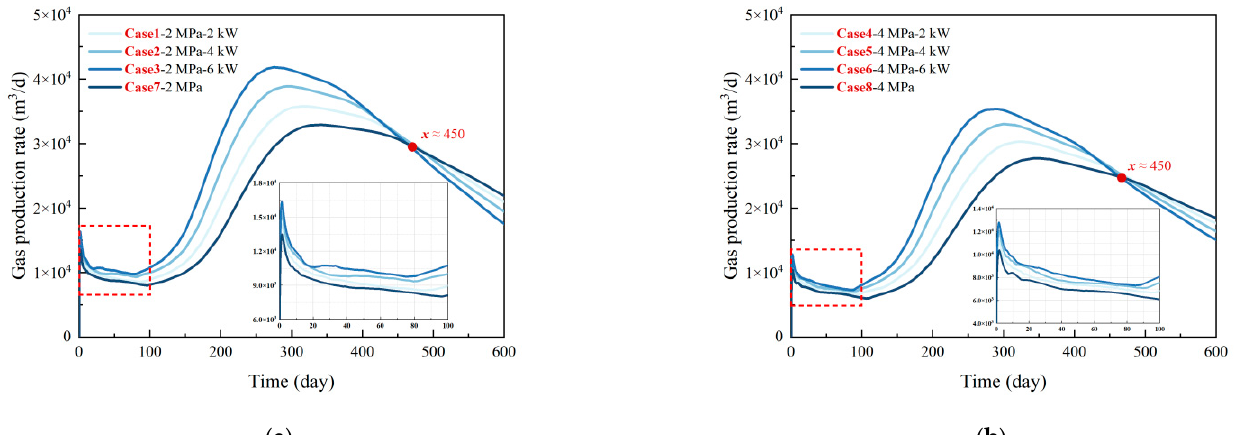
Figure 9. Gas production characteristics: ( a ) production pressure of 2 MPa; ( b ) production pressure of 4 MPa.